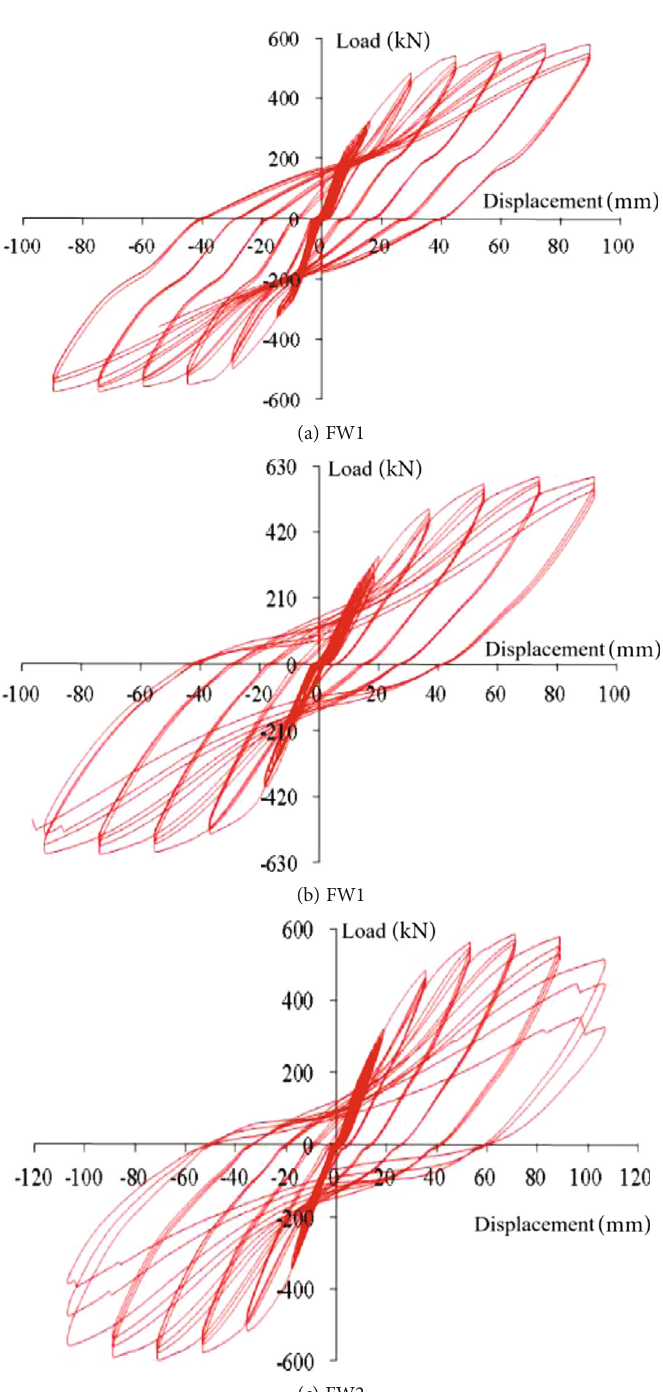
Figure 7: Hysteretic